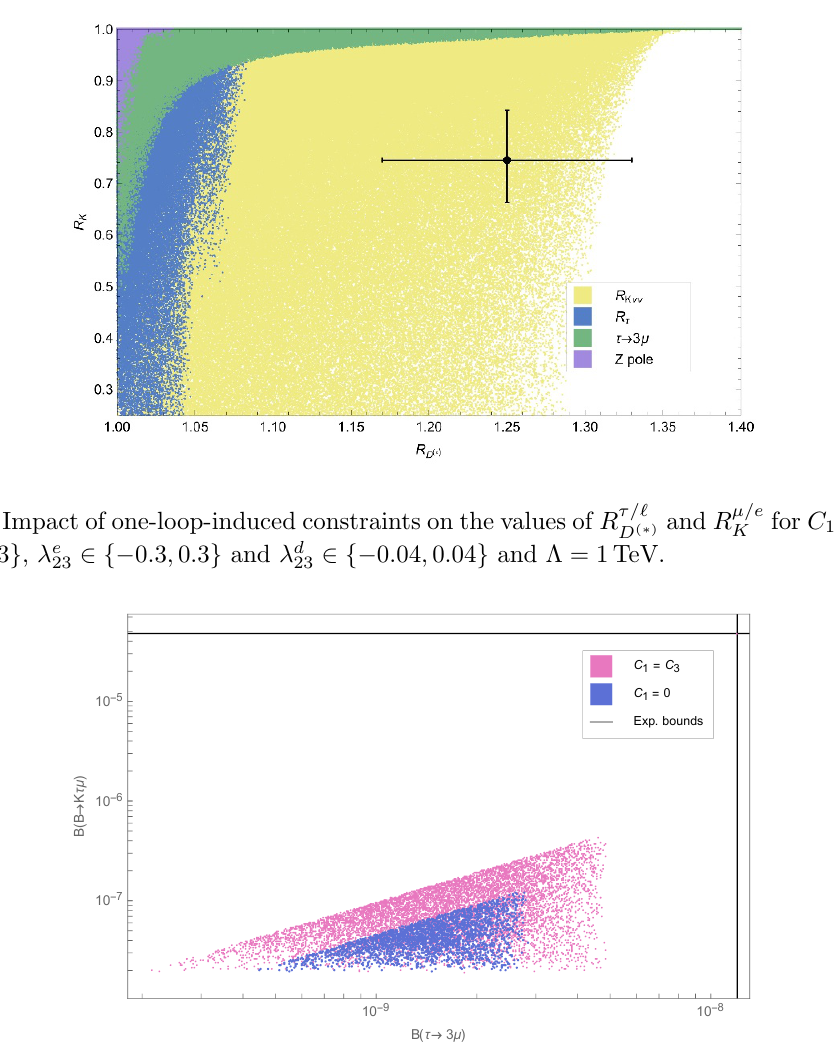
Figure 2 . B ( B ! 3 (cid:22) ) vs. B ( B ! K(cid:28)(cid:22) ) within our model for two di(cid:11)erent con(cid:12)gurations of C 1 , C 3 , imposing all constraints but R (cid:28)=‘ . We let parameters vary in the ranges C 1 2 f(cid:0) 3 ; 3 g , D ( (cid:3) ) C 3 2 f(cid:0) 3 ; 3 g , (cid:21) e 2 f(cid:0) 0 : 3 ; 0 : 3 g and (cid:21) d 2 f(cid:0) 0 : 04 ; 0 : 04 g and (cid:3) = 1 23 23